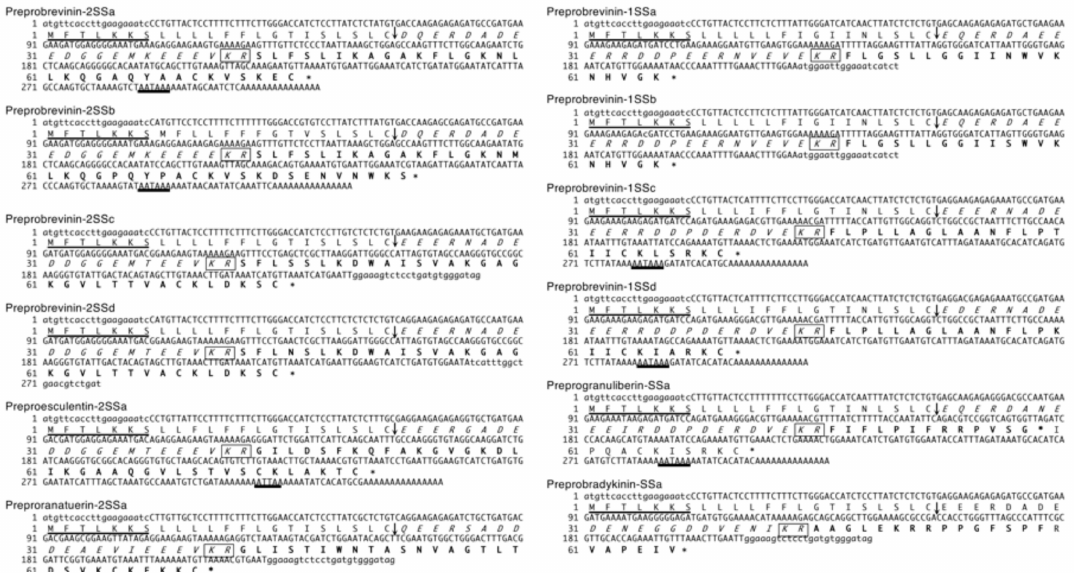
Figure 1. Nucleotide and deduced amino acid sequences of antimicrobial peptide (AMP) precursor cDNAs that were cloned from Glandirana susurra skin. In the nucleotide sequences, forward- and reverse-primer-derived sequences are presented in lowercase. In the amino acid sequences, forward-primer-derived sequences are underlined, intervening sequences are presented in italics, AMP sequences are presented in bold, stop codons are marked with asterisks (*), and cleavage sites for signal peptidase and processing enzymes are marked with arrows and boxes,